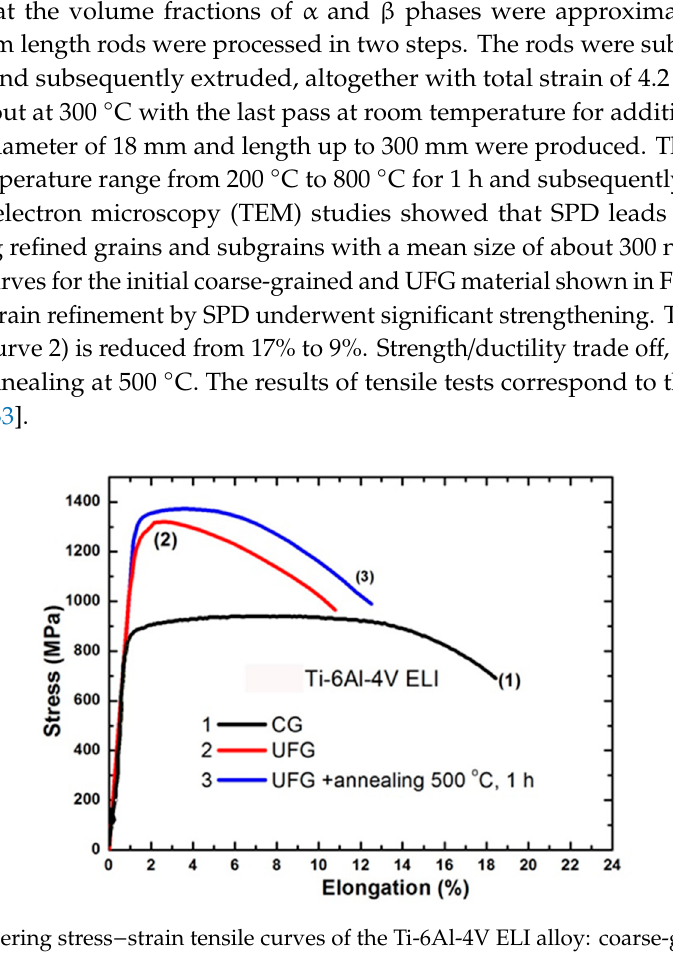
Figure 2. Engineering stress − strain tensile curves of the Ti-6Al-4V ELI alloy: coarse-grained material (initial) (1); UFG condition (2) and UFG condition after annealing at 500 ° С (3).